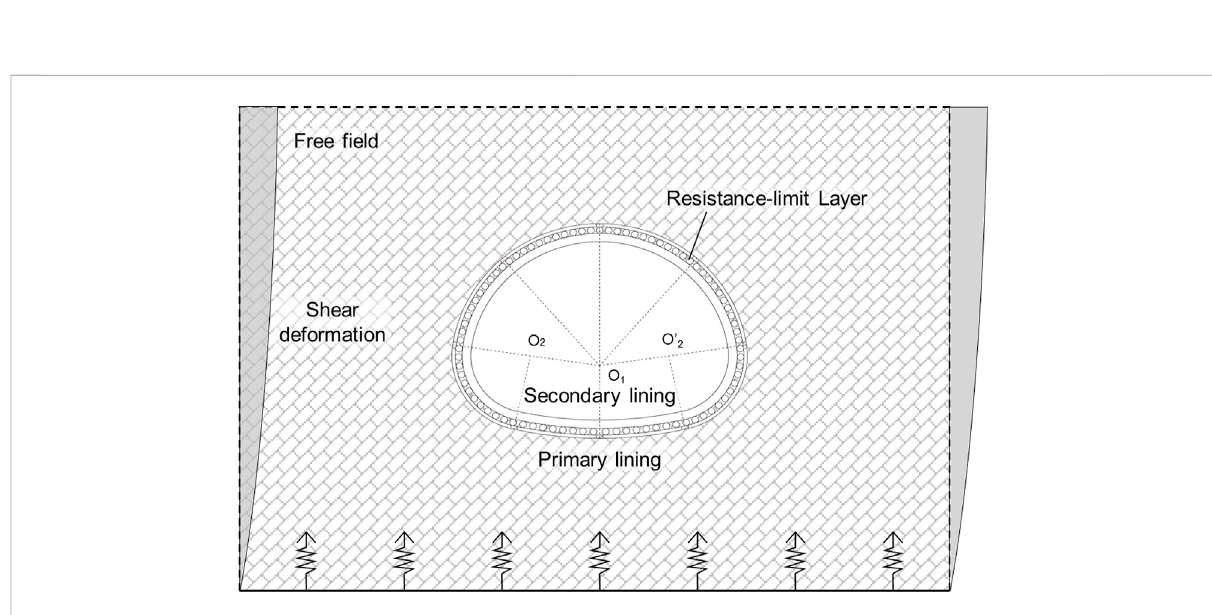
FIGURE 3 Model of the Resistance-limiting shock absorption